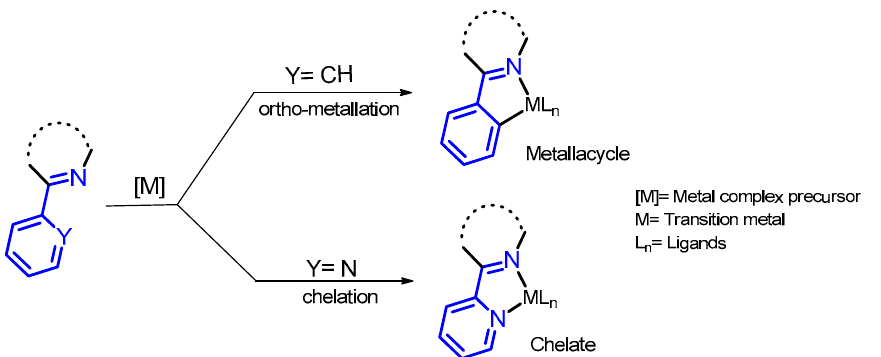
Figure 3. The fragments present in BZD drugs, derived from phenylmethanimine or pyridinylme- thanimine, which are responsible for the reactivity of these compounds, leading to metal com- plexes via ortho -metallation or chelation.